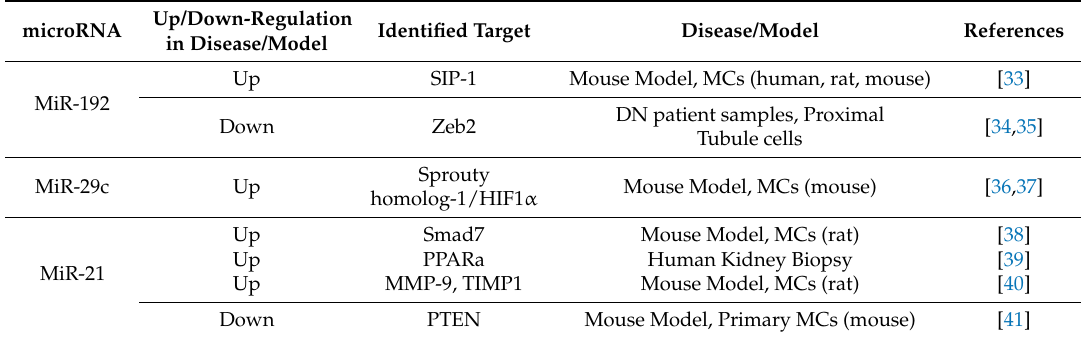
Table 1. MiRNAs implicated in kidney disease pathologies. MCs, mesangial cells. DN, diabetic